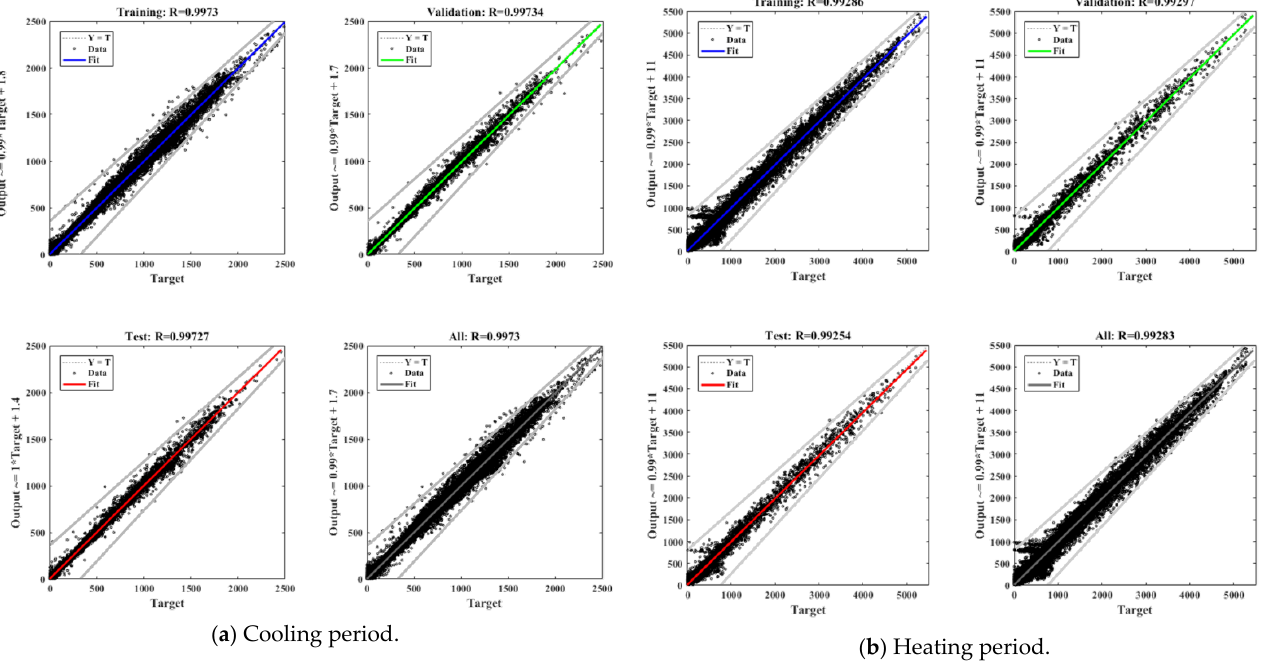
Figure 6. Regression analysis of ANN optimal control model.